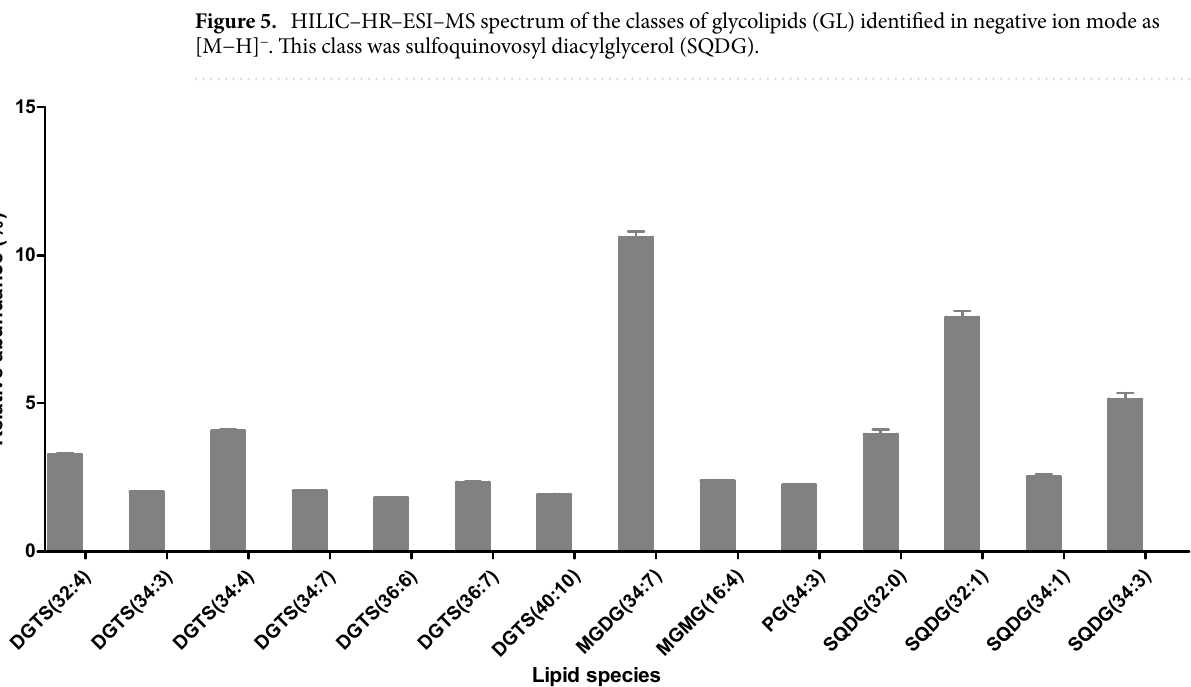
Figure 6. The most abundant lipid species, identified as molecular ions, in the polar lipidome of Chlorococcum amblystomatis , with a relative amount ≥ 1.5%. The results are represented by an average of five samples ± standard